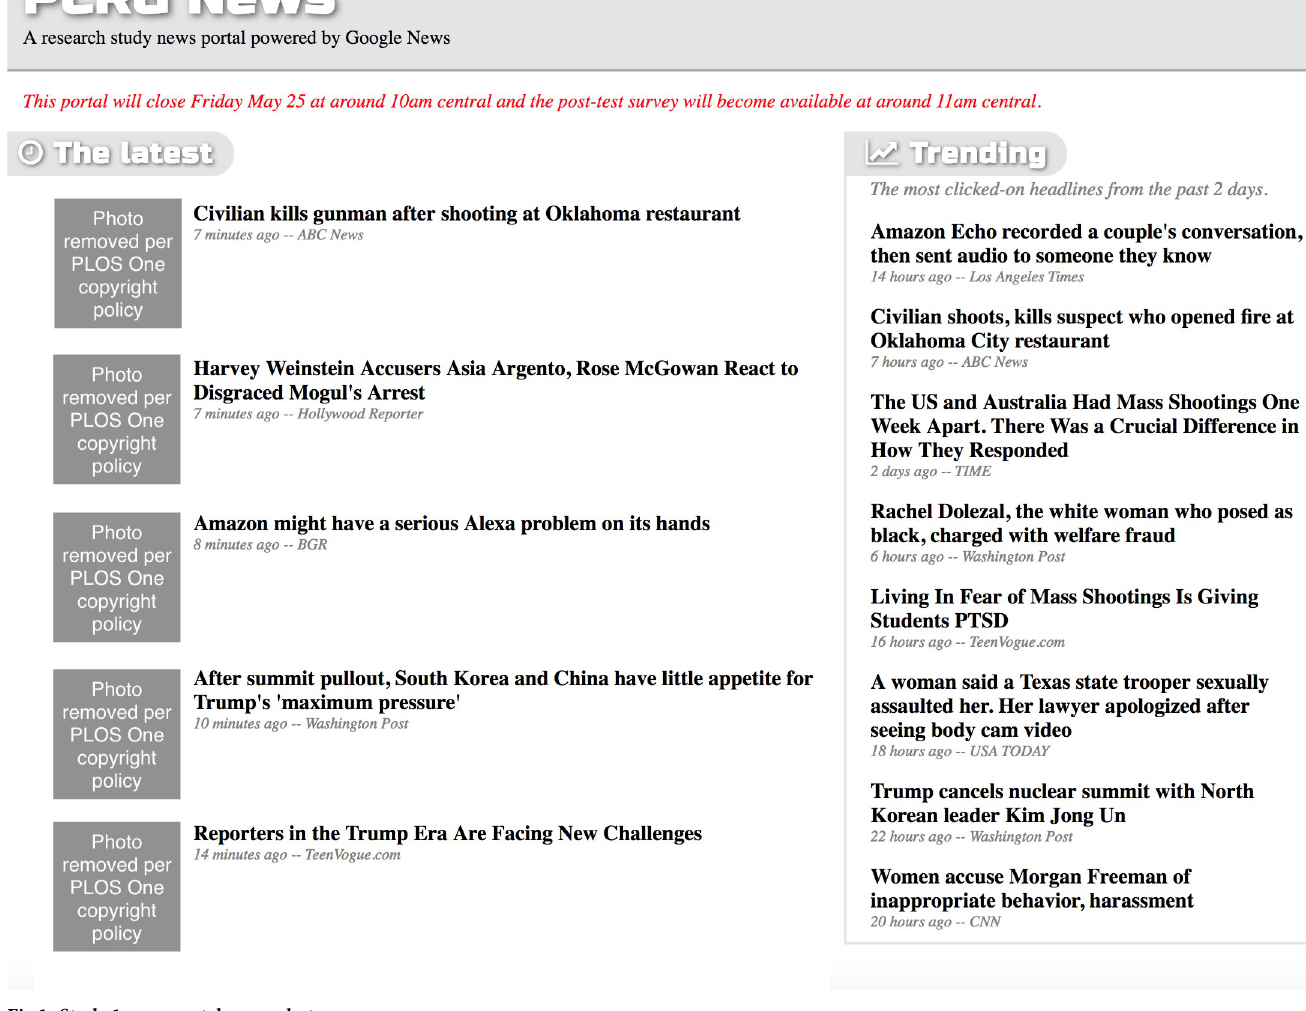
Fig 1. Study 1 news portal